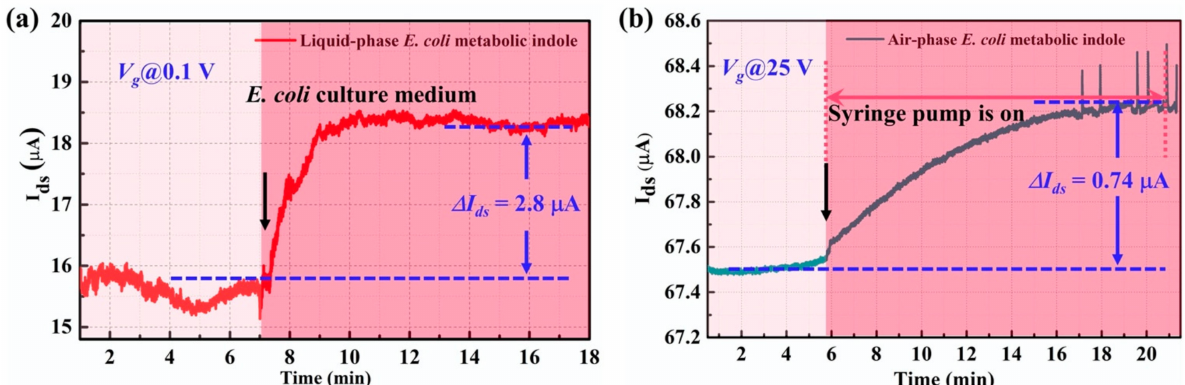
Figure 7. The real-time detection of metabolic volatile indole of E. coli in ( a ) liquid phase and ( b ) gas